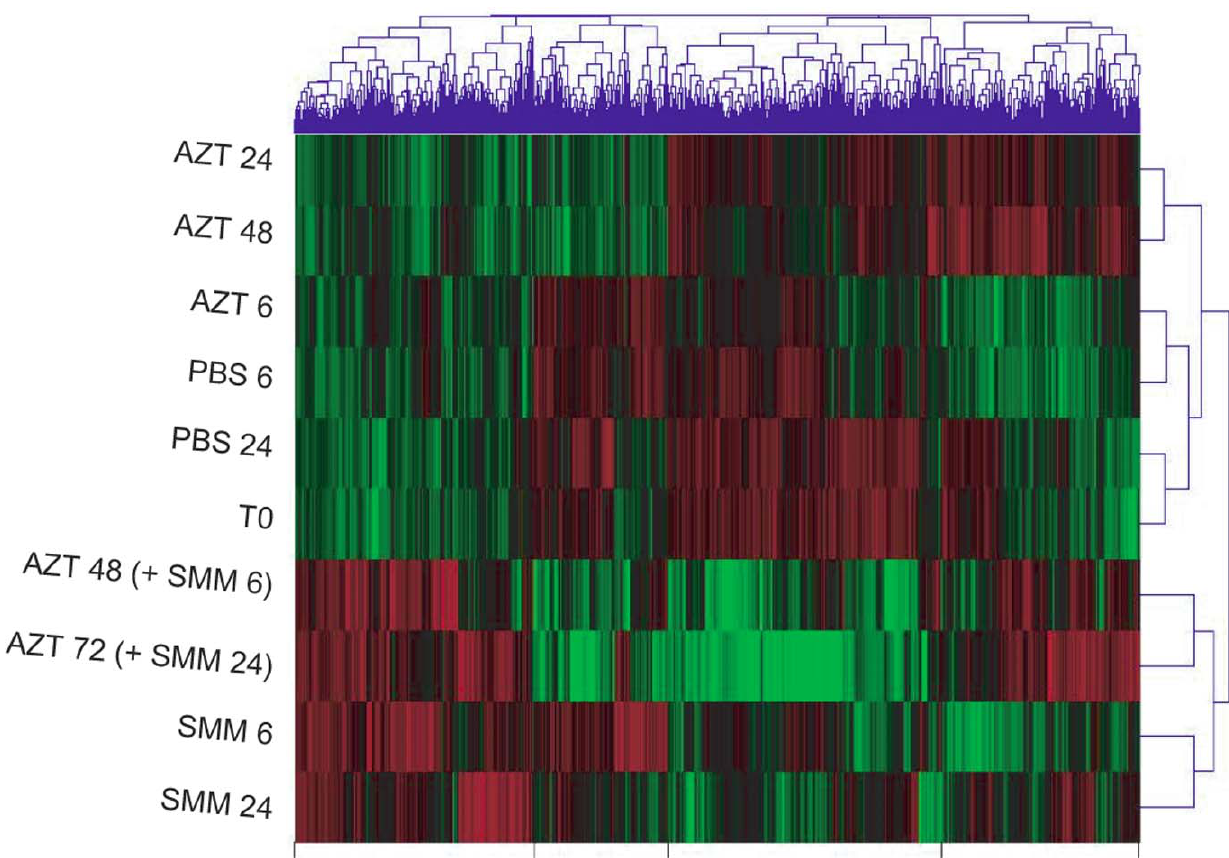
Figure 1. Clustering of the expression data. Clustering of the data, as described in Methods, revealing the general organization of differential gene expression. Green color represents reduced gene expression relative to red color, which represents increased expression. Treatments are explained in Table 1. PBS: phosphate buffered saline. AZT: azithromycin. SMM: Supernatant of mucopurulent material from CF airways.